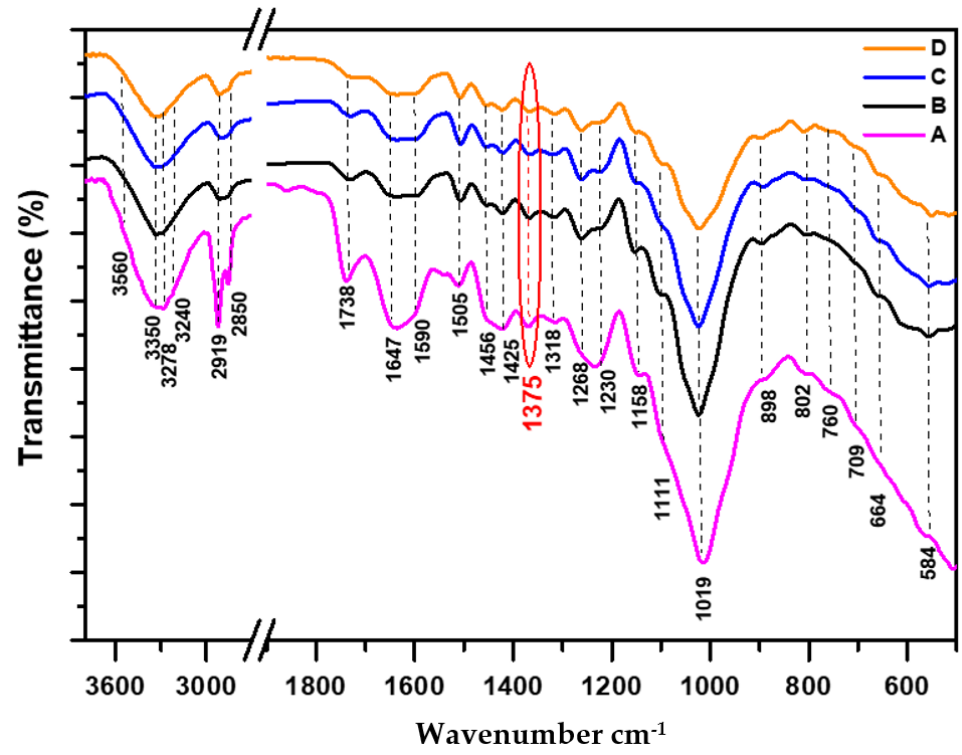
Figure 1. FTIR spectra of non-degraded cedar wood samples normalized at 1375 cm −1 : (A: 21st century, B: 19th century, C: 17th century, D: 16th century).